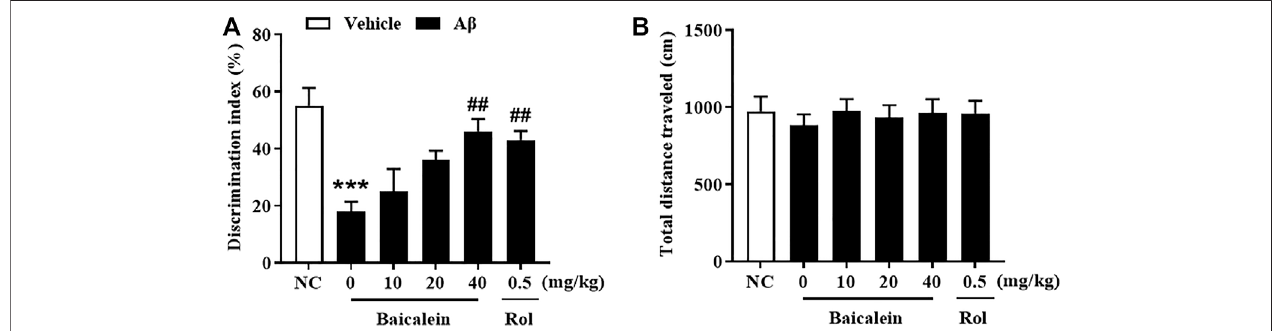
FIGURE2| BaicaleinimprovedcognitivefunctionofA β -treatedmiceinthenovelobjectrecognitiontest. (A) Thediscriminationindexwasshownbytheratiooftime spentexploringthenovelobjecttothefamiliarone. (B) Thetotaldistancetraveledofmicedidnotchange.Allvalueswereexpressed asmean ± SEM( n (cid:2) 6).*** p < 0.001 vs. normal control (NC) mice; ## p < 0.01 vs. A β -treated mice.